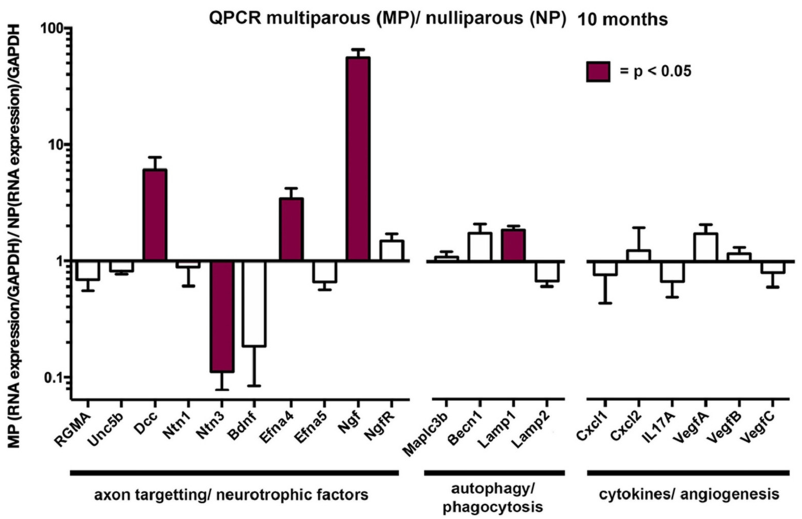
Figure 5. Parity leads to elevated expression of corneal epithelial mRNAs for Ngf, Dcc, Efna4, and Lamp1 and reduction expression of Ntn3 in female mice at 10M. RNA was isolated from the epithelium of 10M NP and MP mice and used for qPCR studies to look at expression of 20 RNAs involved in maintaining the corneal sensory nerves. Data for NP and MP RNA are normalized by GAPDH and presented as a ratio of MP/NP. Values above 1 indicate increased expression in MP and values less than 1 indicate reduced expression. Data that are significant are shown in maroon.